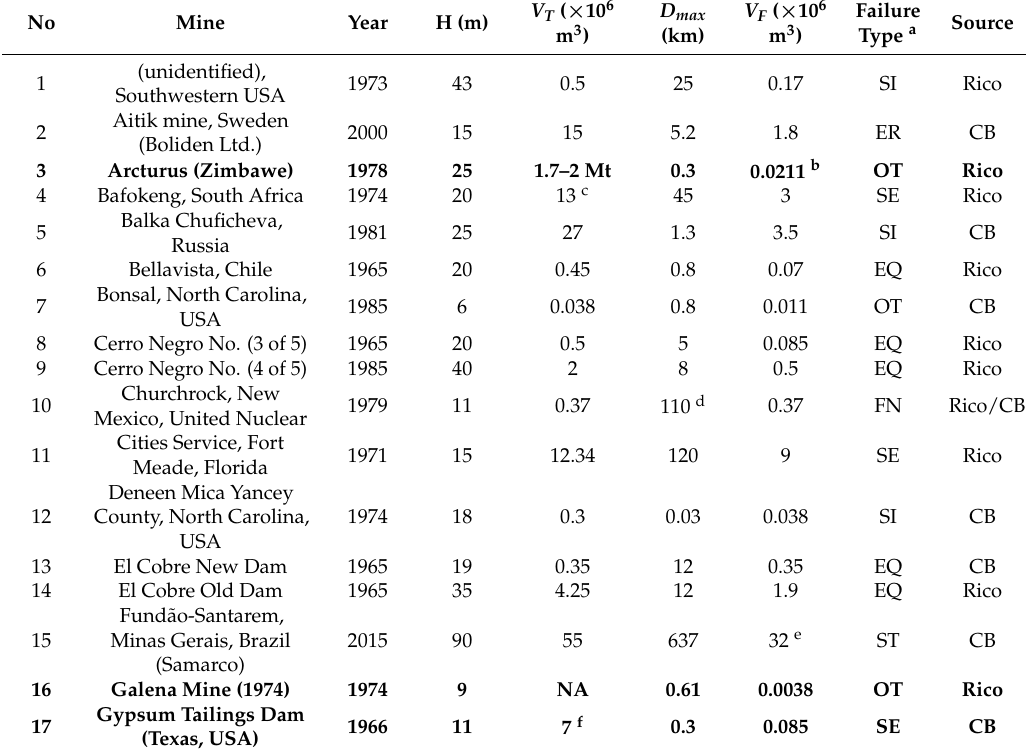
Table 1. Data in Rico et al. [10] and Chambers and Bowker (CB) [15]. Entries in red are